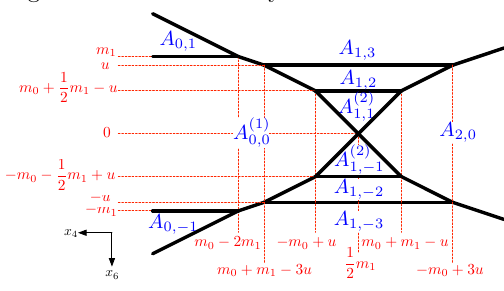
in Figure 22. The regions for the largest A ( m ) k;l Region 2 of the E 2 theory.